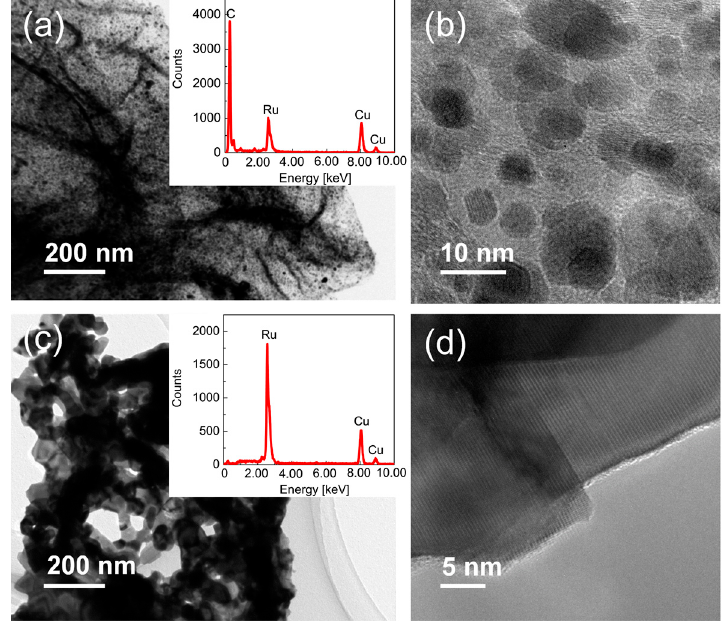
Figure 9. TEM images of CS ‐ 60 ( a , b ) and SS ‐ 40 ( c , d ) nanocomposites after catalytic ammonia decomposition at 450 °C for 80 h, and at 500 °C for 20 h. Insets in ( a ) and ( c ) are the EDX results of the use of CS ‐ 60 and CS ‐ 40, respectively.